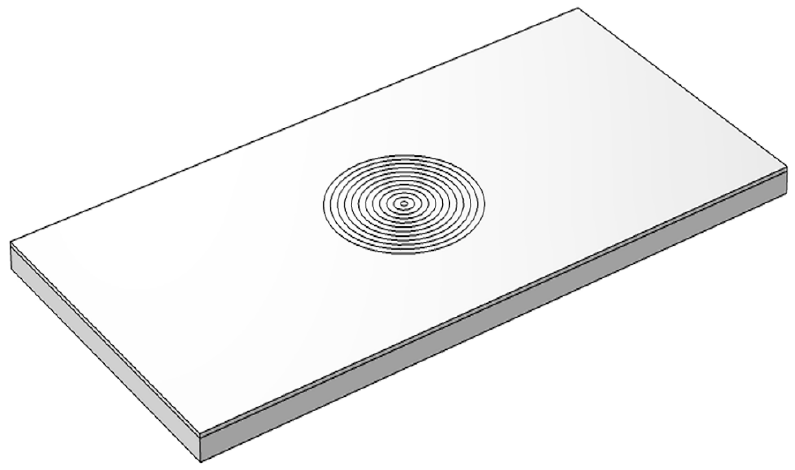
Figure 2. Simulation